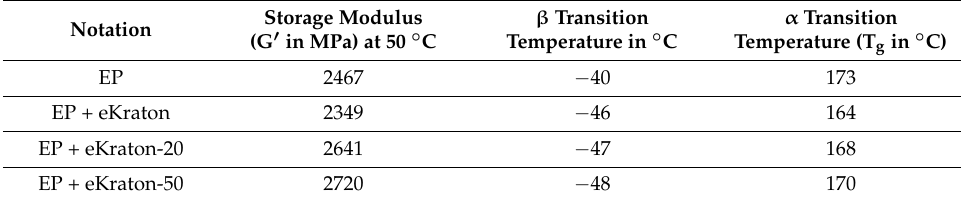
Table 2. Storage modulus and transition temperature values obtained from DMA curves.